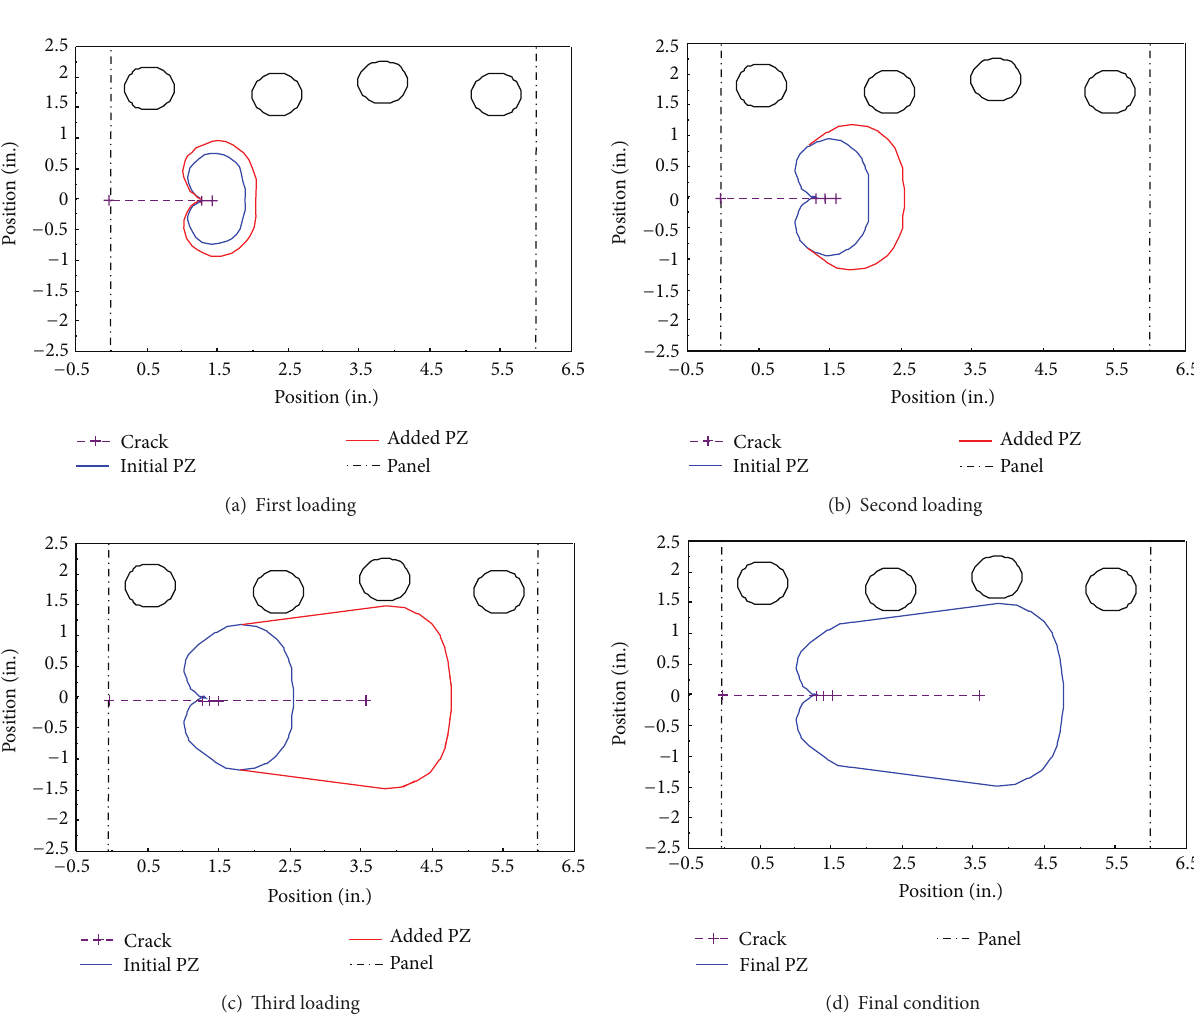
Figure 14: Crack location and sensor placement. Plastic zone is shown around the propagating crack tip. Sensors are labeled Channels 1 to 4 from right to